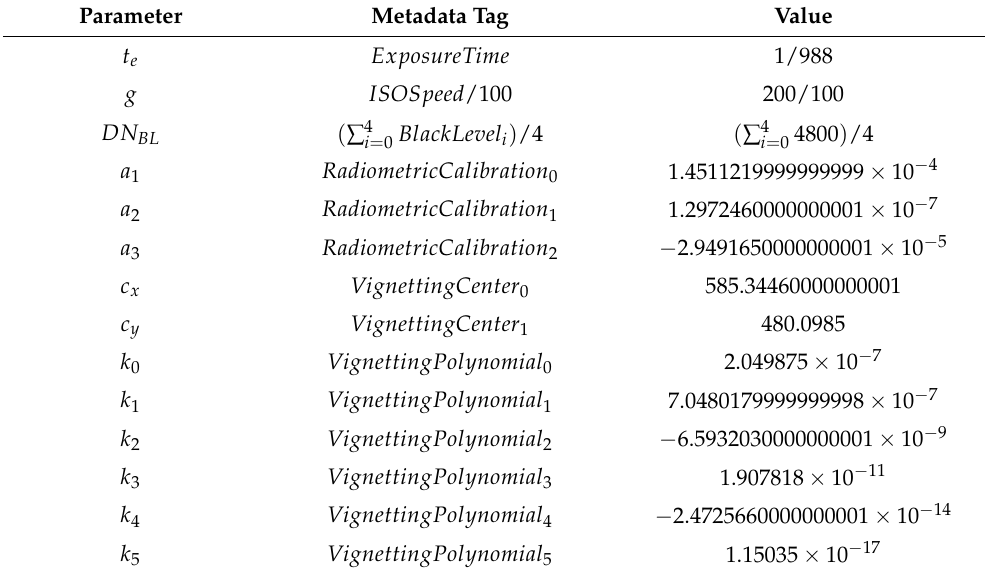
Table 2. Parameters used to convert raw images to radiance images and their corresponding values and tags extracted from the metadata embedded in the raw